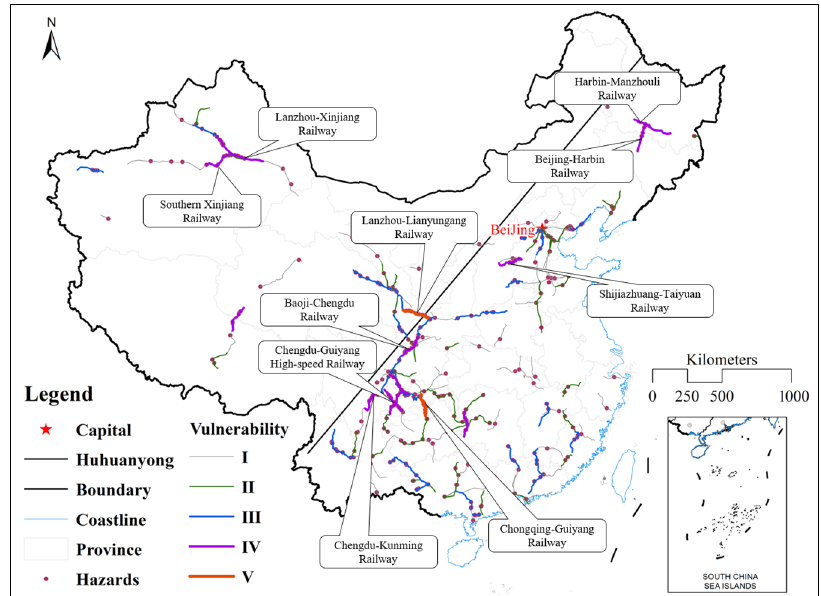
Figure 12. Vulnerability Analysis of Railways Under the Integrated Geological Hazards. Table 4. The Most Vulnerable Sections in the Railway Lines.